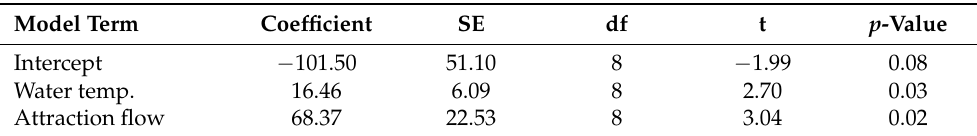
Table 4. Fixed effects from the top Generalized Linear Mixed Model to explain the number of suckers transported by the